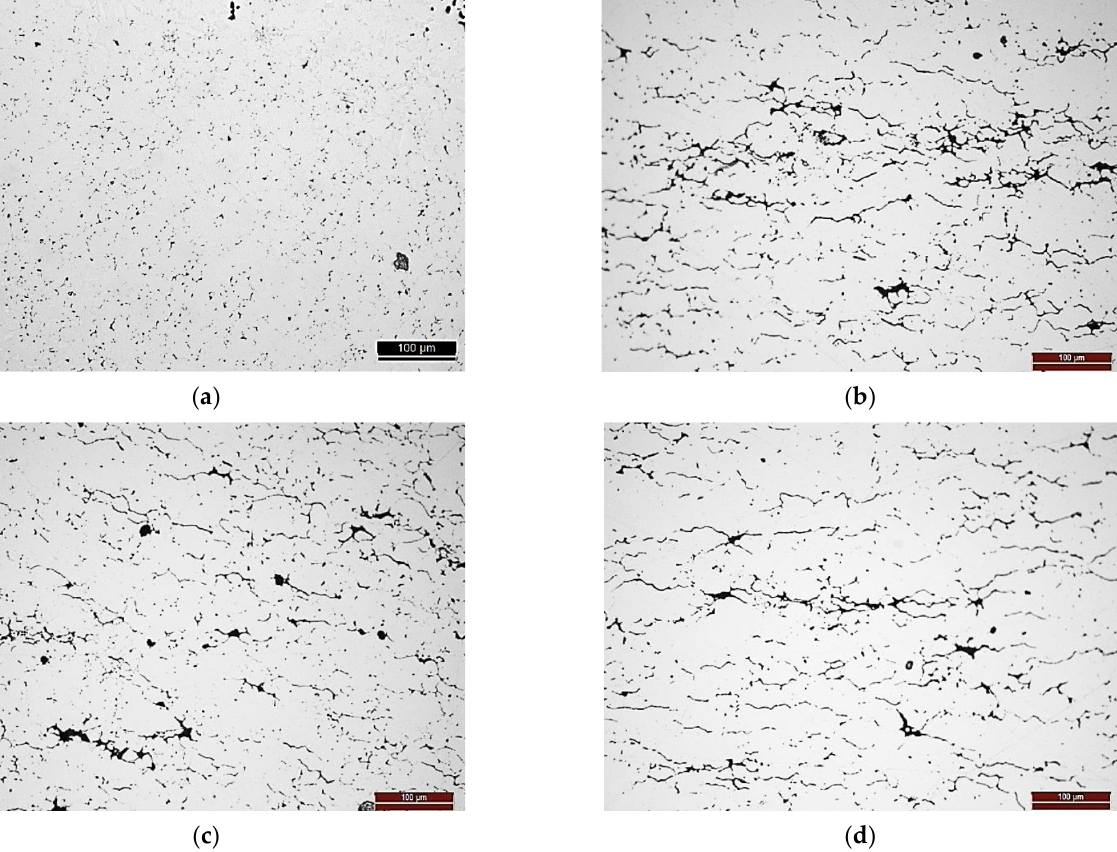
Figure 2. OM images of the samples heat-treated at 1100 °C for 30 min: ( a ) Ni sample, ( b ) Ni-0.50 vol.% CNT, ( c ) Ni-0.75 vol.% CNT and ( d ) Ni-1.00 vol.% CNT.